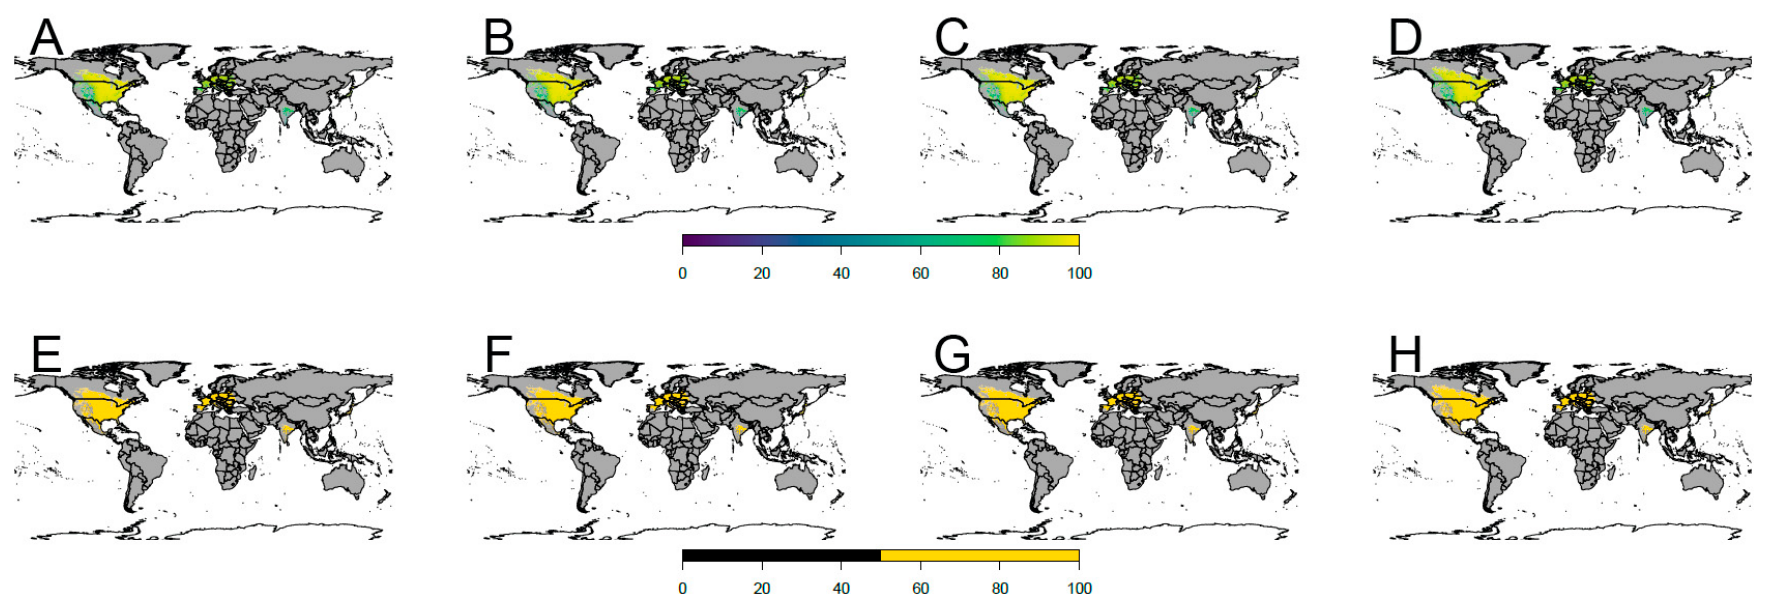
Figure 4. Distribution maps of the Japanese beetle estimated under future conditions (accounting for species dispersal distance) derived from INLA SPDE. ( A – D ) yellow–blue scale indicates higher–lower occurrence probability values, respectively, ( E – H ) areas of predicted species occurrence estimated using a threshold value of 50.3 (threshold values estimated by maximizing TSS), presence shown in orange, while absence shown in black. Panels ( A , E ) refer to the future climatic scenario RCP 2.6, ( B , F ) to RCP 4.5, ( C , G ) to RCP 7, while ( D , H ) to RCP 8.5. Areas of uncertain prediction identified by mMESS, and those with DD values below the threshold of 711, are shown in grey.